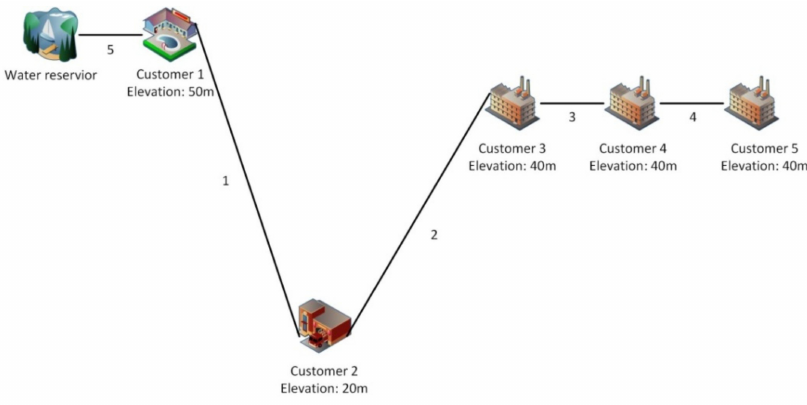
Figure 2. An example of valve